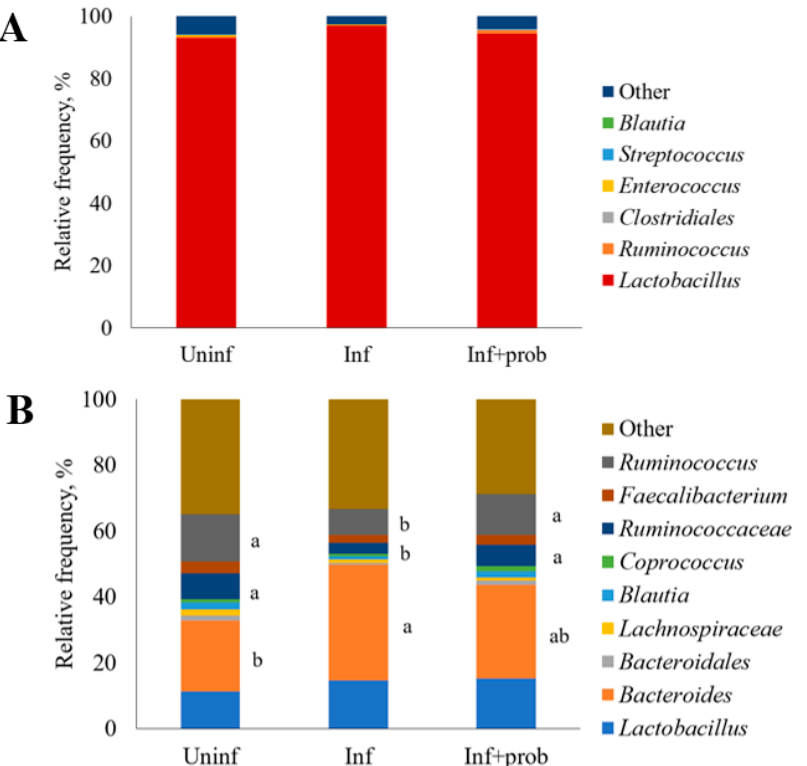
Figure 2. Relative frequency (%) of the main bacterial groups present in the ileal digesta ( A ) and cecal content ( B ) microbiota of broilers challenged with an experimental model to reproduce NE and supplemented with Bacillus subtilis DSM 31325. Means of the same bacterial group followed by different letters (a,b) are different by Dunn test ( p ≤ 0.05).